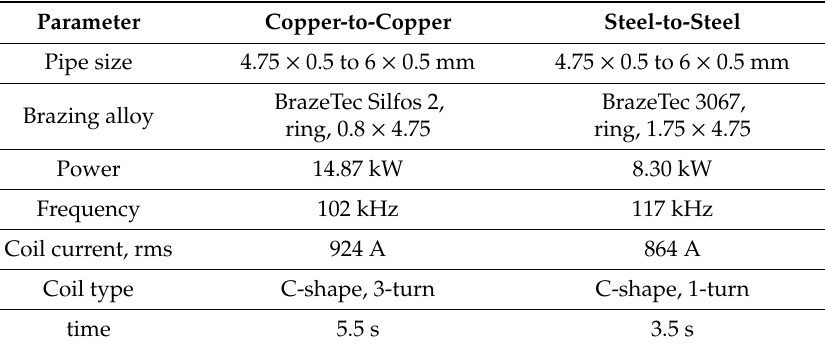
Table 2. Laboratory test results